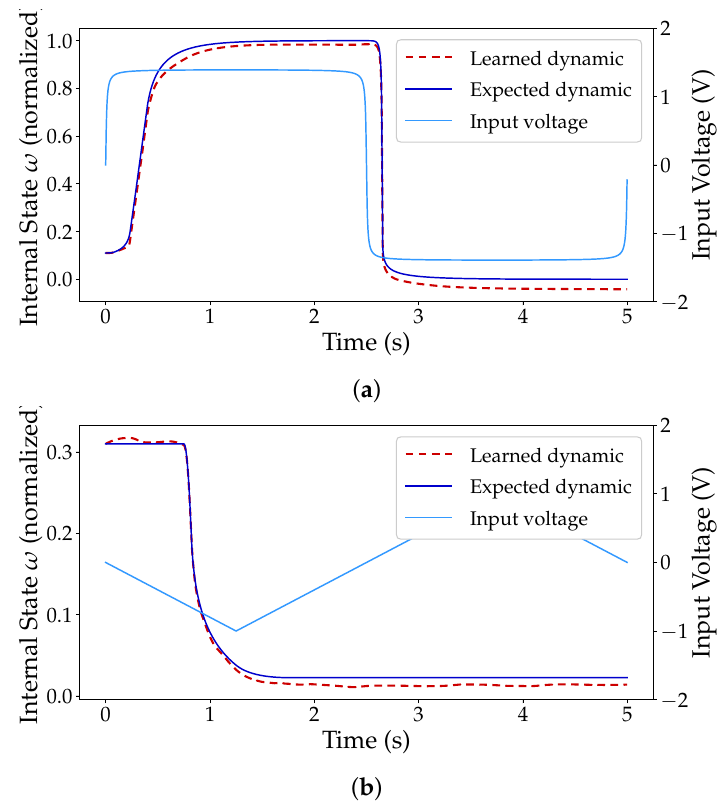
Figure 5. Expected dynamics of a simulated Pt-TiO 2 − x memristor and the output of an MSNN network with external input and [ 2,50,50,50,1 ] topology. ( a ) Output of the network to a square- shaped periodic input. ( b ) Output of the network to a triangular-shaped periodic